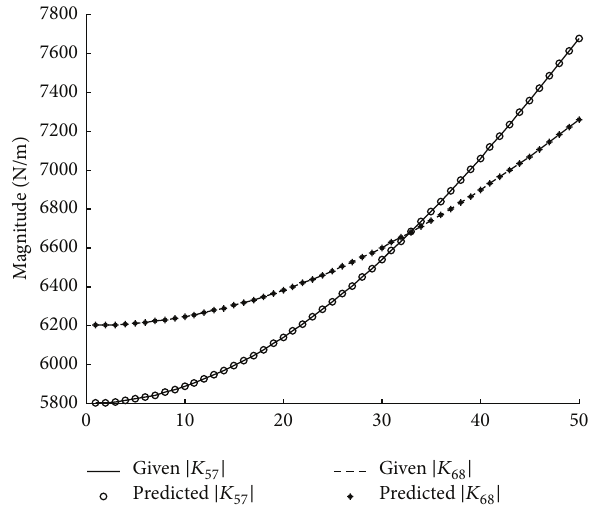
Figure 5: Comparison of predicted and exact coupling dynamic stiffness; here, 𝐾 57 = 𝑘 57 + 𝑗𝜔𝑐 57 , 𝐾 68 = 𝑘 68 + 𝑗𝜔𝑐 68 .